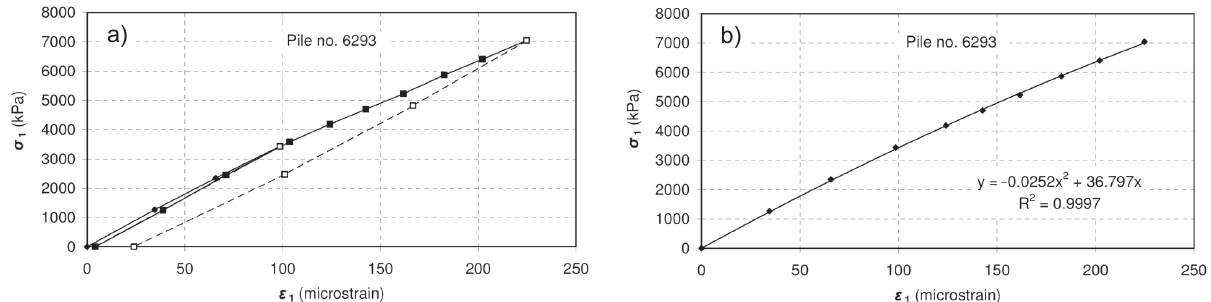
Figure 1: The stress–strain relation measured in the first section of the pile (pile no. 6293): a) general for loading and unloading, b) only for loading, described by a